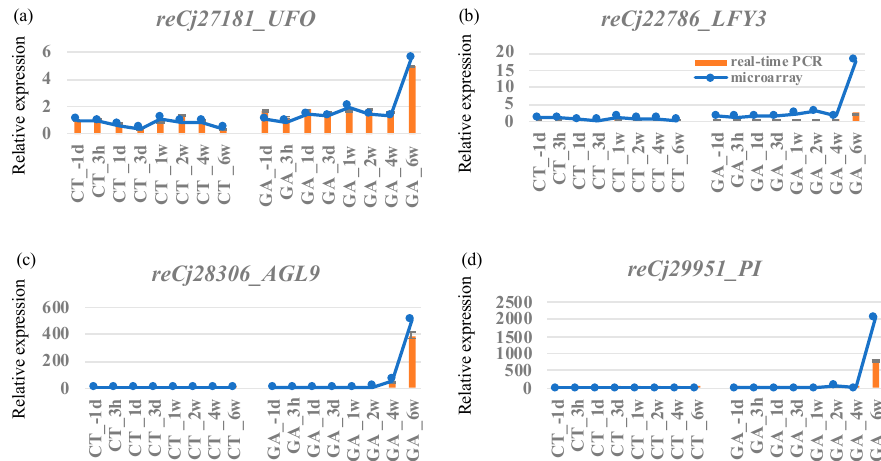
Figure 8. Real-time PCR validation of DEGs data. Bar graphs show relative expression from real-time PCR and line graphs show raw data signals from microarray analysis. Data are presented as mean + standard deviation (n = 3). ( a ) reCj27181 _ UFO , ( b ) reCj22786 _ LFY3 , ( c ) reCj28306 _ AGL9 , ( d ) reCj29951 _ PI